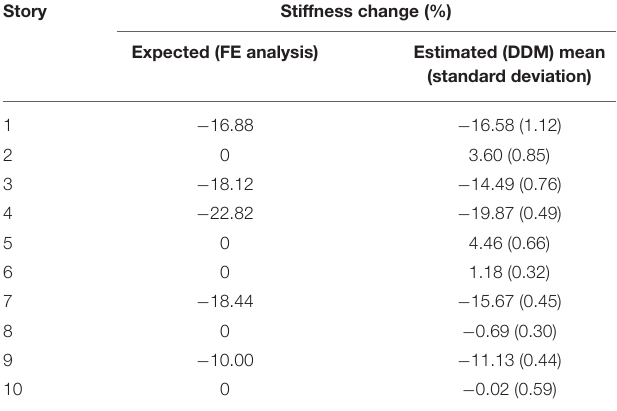
TABLE 8 | Story stiffness change (DC C2).